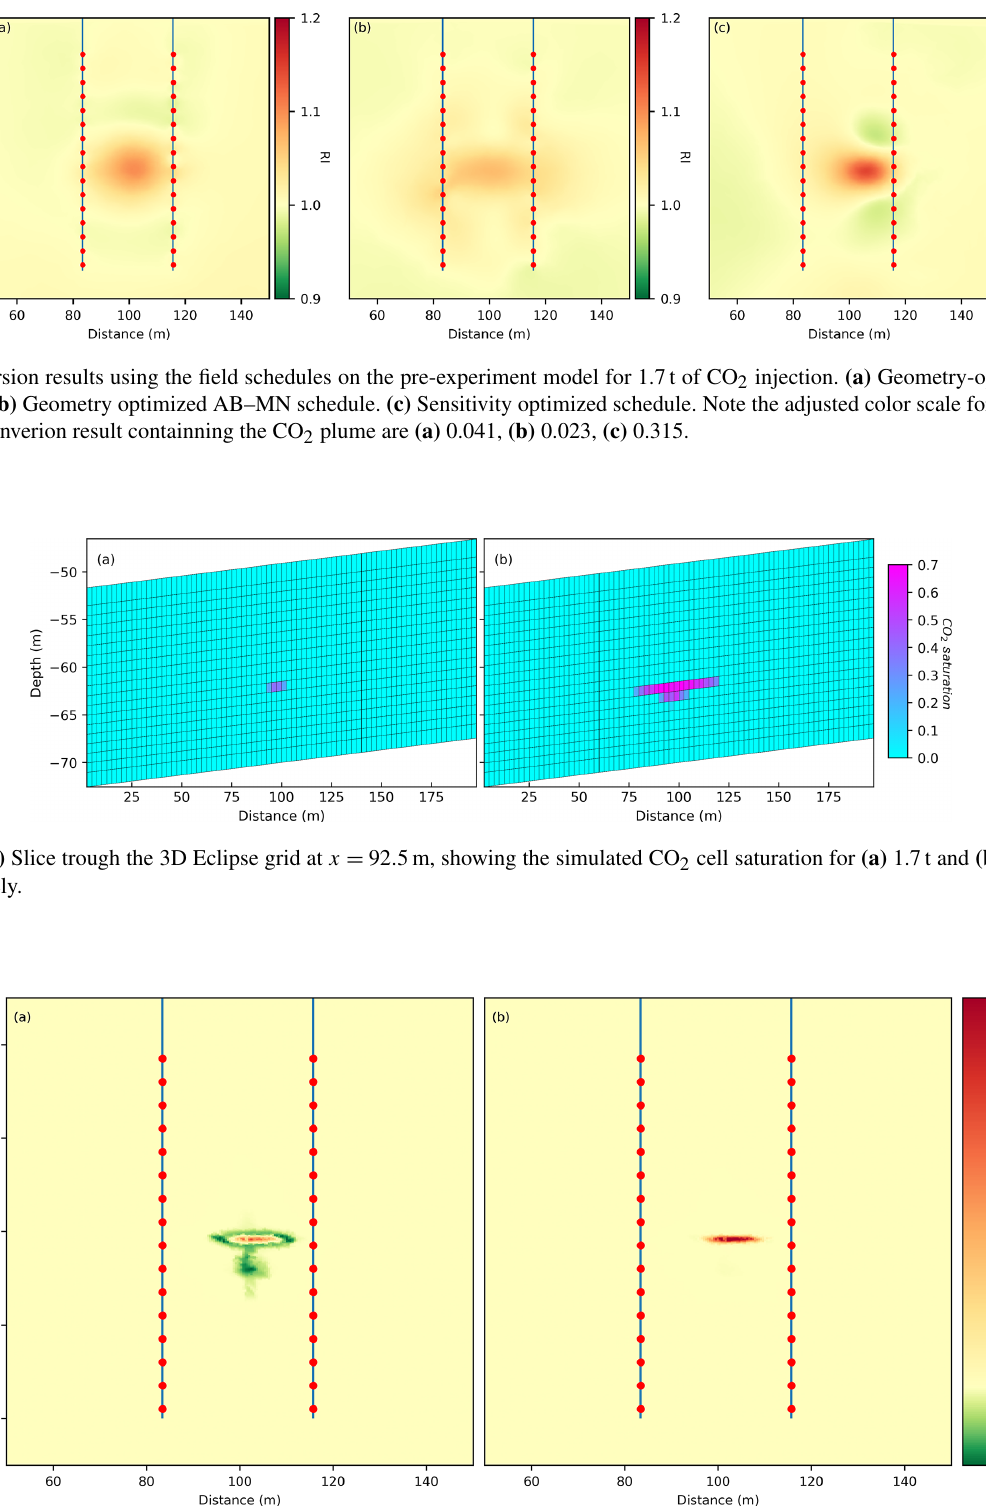
Figure 9. Slice through the 3D reservoir model in terms of resistivity index R/R 0 for 1.7t of CO 2 injection. (a) CaCO 3 bearing aquifer. (b) CaCO 3 free